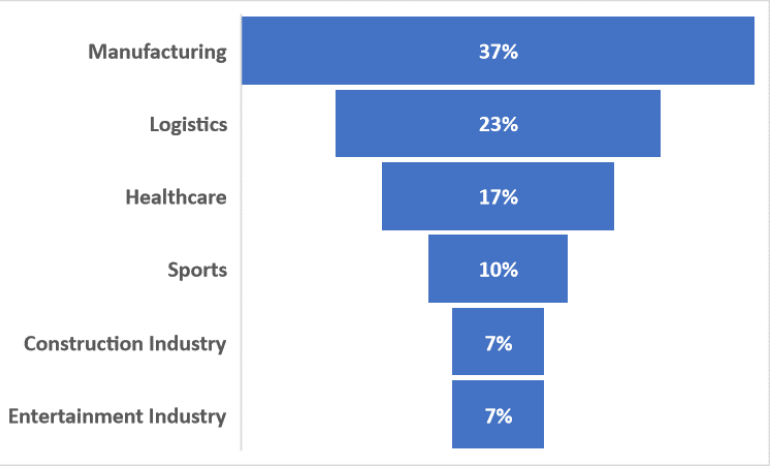
Figure 8. Comparison of field publication percentage. Source: own processing.